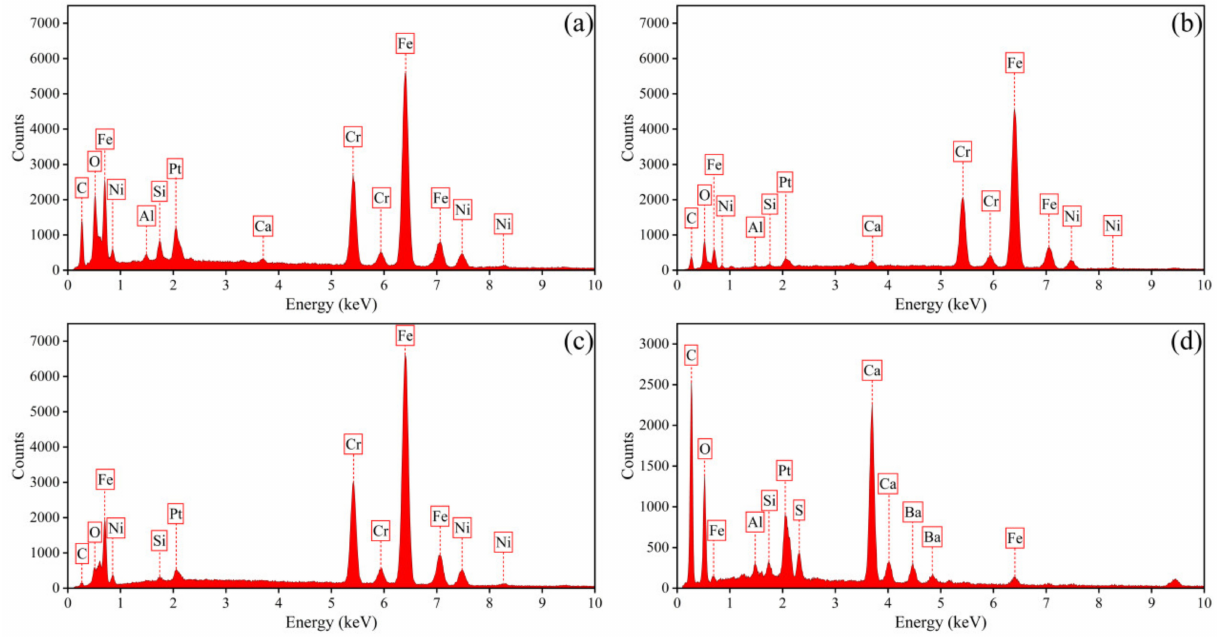
Figure 15. EDS diagram of the surface after water jet-guided laser cleaning with different laser frequencies. ( a ) Region A; ( b ) Region B; ( c ) Region C; ( d ) Region